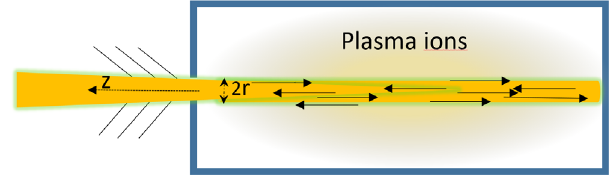
FIG. 2. Schematic view of a magnetic flux tube in a proton source. Because of the negligible radial diffusion, ions move along a magnetic tube flux tube toward the extraction hole [27].